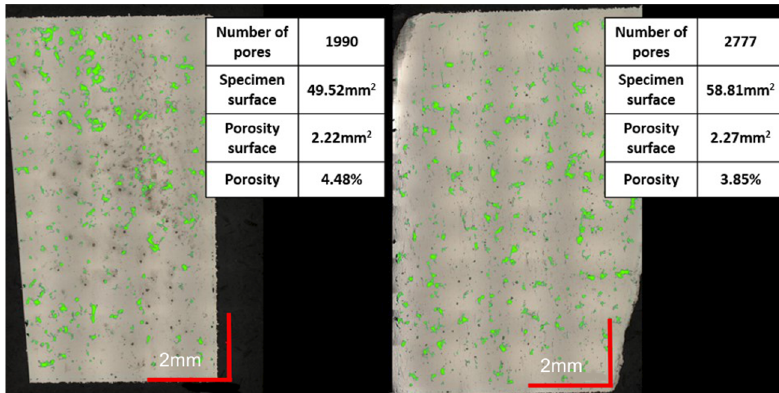
Figure 10. Presentation of porous specimen surface analysis (green color).